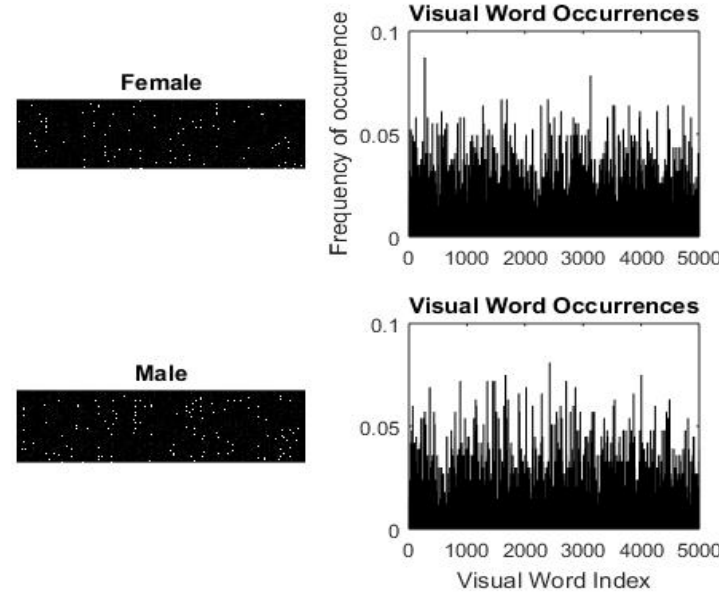
Fig. 3. Histogram of features